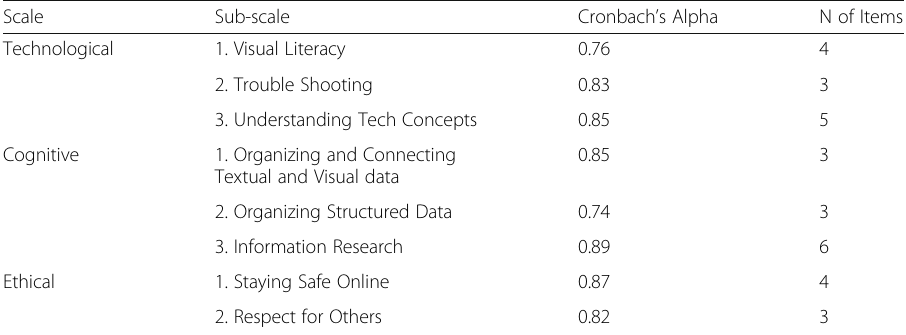
Table 3 Internal consistency reliability